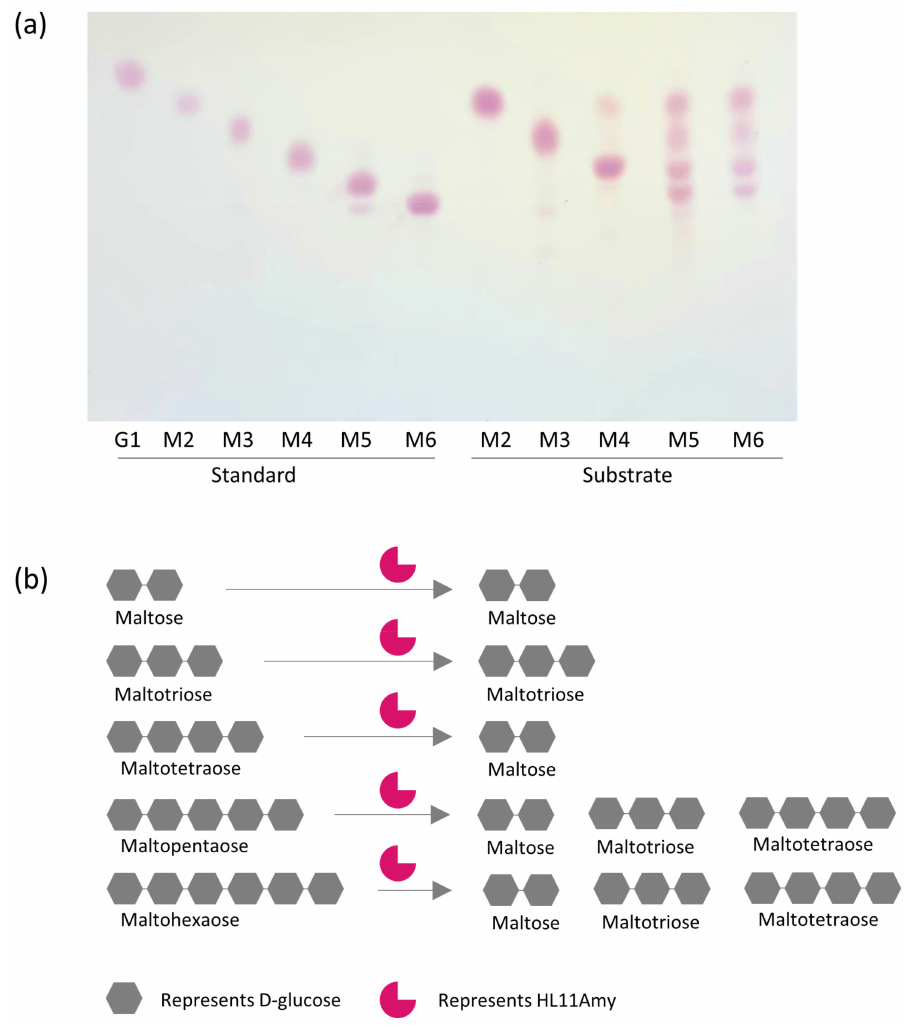
Figure 6. Specific cleavage pattern of HL11Amy on maltooligosaccharides with different degrees of polymerization 2–6. The obtained final products analyzed using ( a ) TLC technique. ( b ) Schematic diagram of specific cleavage pattern of HL11Amy represented mode of action of HL11Amy on maltooligosaccharides with different degrees of polymerization and the obtained final products. G1 represents glucose, M2 represents maltose, M3 represents maltotriose, M4 represents maltotetraose, M5 represents maltopentaose and M6 represents